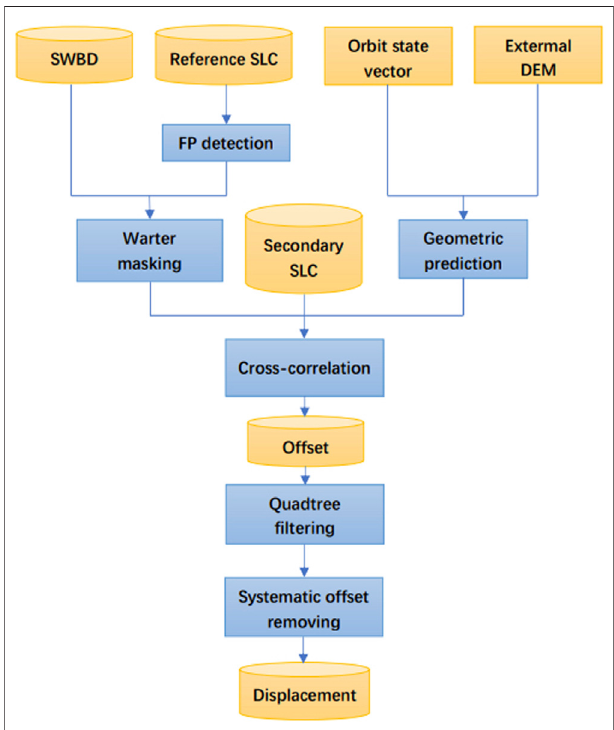
FIGURE 3 | Flowchart of the FPOT